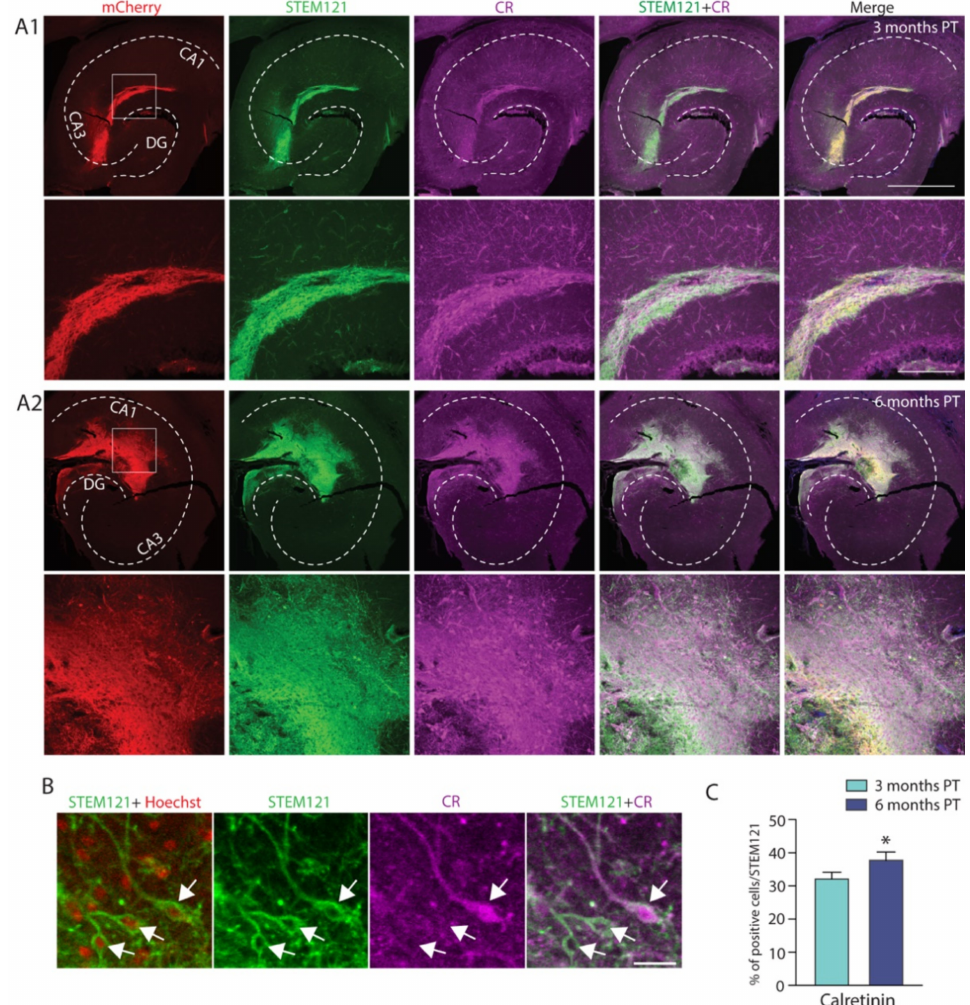
Figure 8. Grafted hdInts express the interneuron subpopulation marker calretinin. ( A ) Grafted hip- pocampal sections stained for mCherry (marker for ChR2; red), human cytoplasm (STEM121; green), and calretinin (CR; magenta), merged with Hoechst (blue) in the last right column. STEM121+ cells expressing CR were observed at both three months PT ( A1 ) and six months PT ( A2 ). ( B ) A merged image of STEM121 and Hoechst was used for counting all STEM121+ cells, merged image of STEM121 and CR staining was used for counting STEM121+CR+ double-positive cells. Arrowheads indicate counted cells. ( C ) Quantification of cells stained for STEM121 and CR. Note that the percentage of cells co-expressing both CR and the human cytoplasm marker was significantly higher at six months PT compared to three months PT. *, p < 0.05. Unpaired t -test was used for comparison of means in ( C ). Dashed white line in ( A1 , A2 ) represents the anatomical structure of the hippocampus. Scale bars: 1 mm (( A1 , A2 ) upper row), 200 µ m (( A1 , A2 ) lower row) and 20 µ m ( B